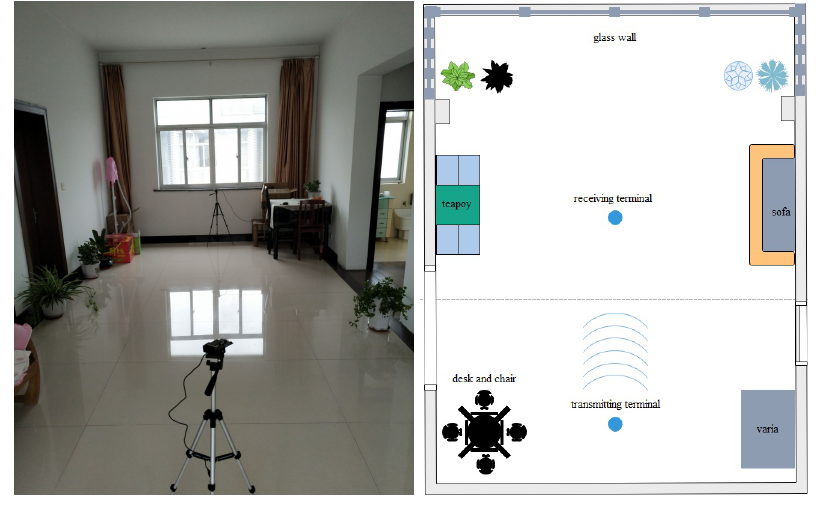
Fig. 1 Experiment